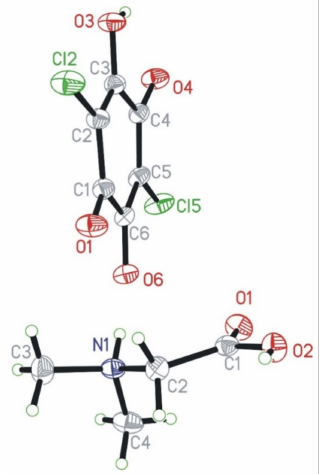
Figure 1. Numbering scheme for N,N-dimethylglycine cation (bottom) and chloranilic acid anion (top). The independent amino acid molecules are denoted with the capital letters A and B, whereas the chloranilic acid are indicated with C and D, respectively. Independent molecules of every kind have very similar geometries.